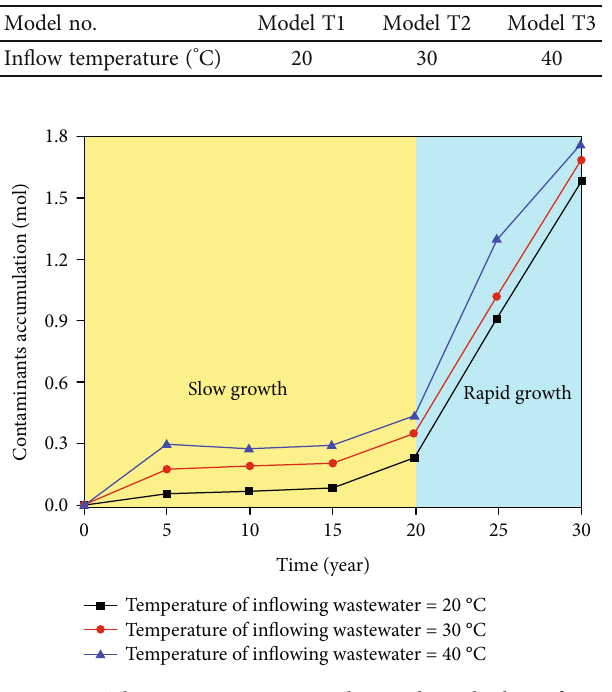
Figure 17: The contaminant accumulation along the line of CD under di ff erent in fl ow